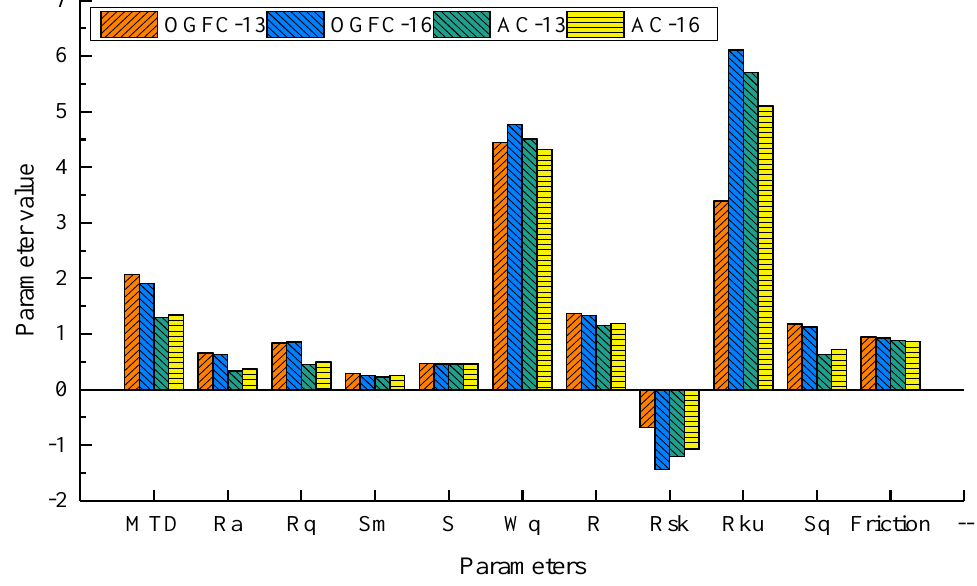
Figure 14. The histograms of the data distribution of macrotexture parameters and friction coeffi- cients.